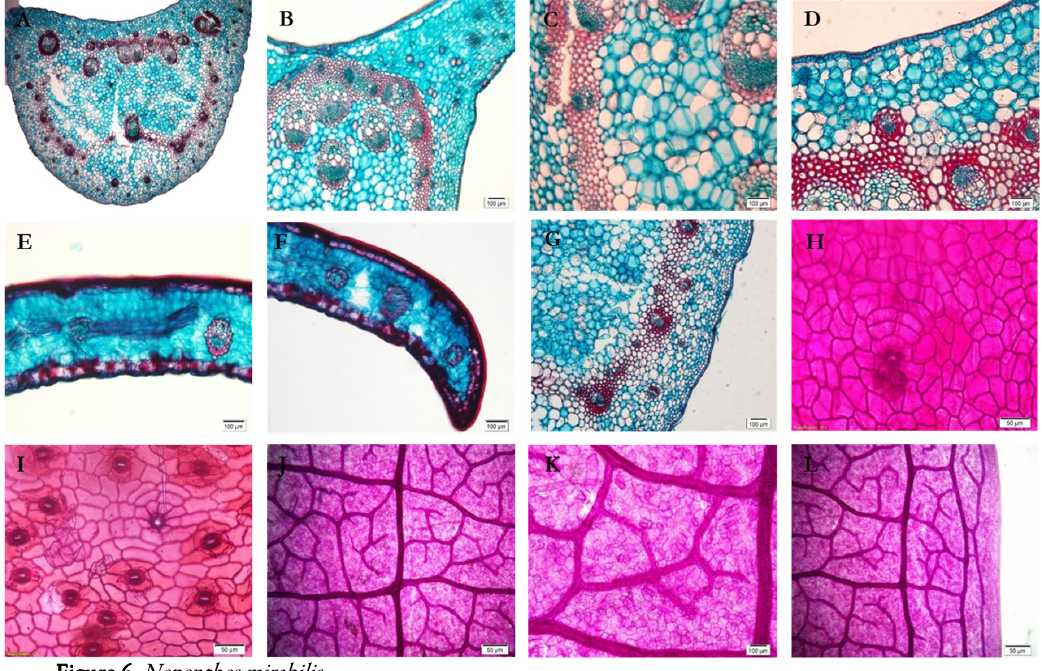
Figure 6. Nepenthes mirabilis (A) Midrib TS. (B) Vascular bundles. (C) Solitary crystals. (D) Solitary crystals. (E) Lamina TS. (F) Margin TS. (G) Simple, unicellular trichomes. (H) Adaxial epidermis. (I)Abaxial epidermis with stomata observation. (J) Lamina venation. (K) Areolar venation. (L) Margin venation. Bars A, H, I, J, L: 50µm; B, C, D, E, F, G, K: